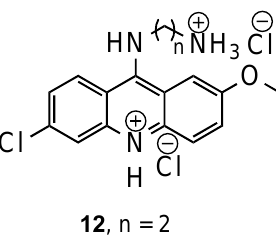
Figure 7. Most active compound 12 developed by Guetzoyan and co-workers [17].